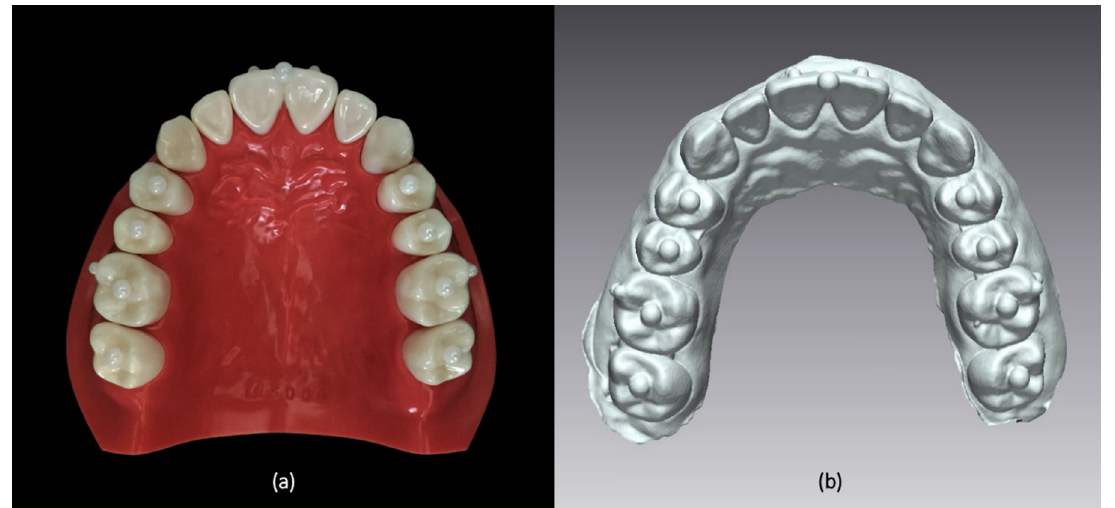
Figure 2. ( a ) A true model prepared with acrylic typodont and nine zirconia balls. ( b ) Digitized model